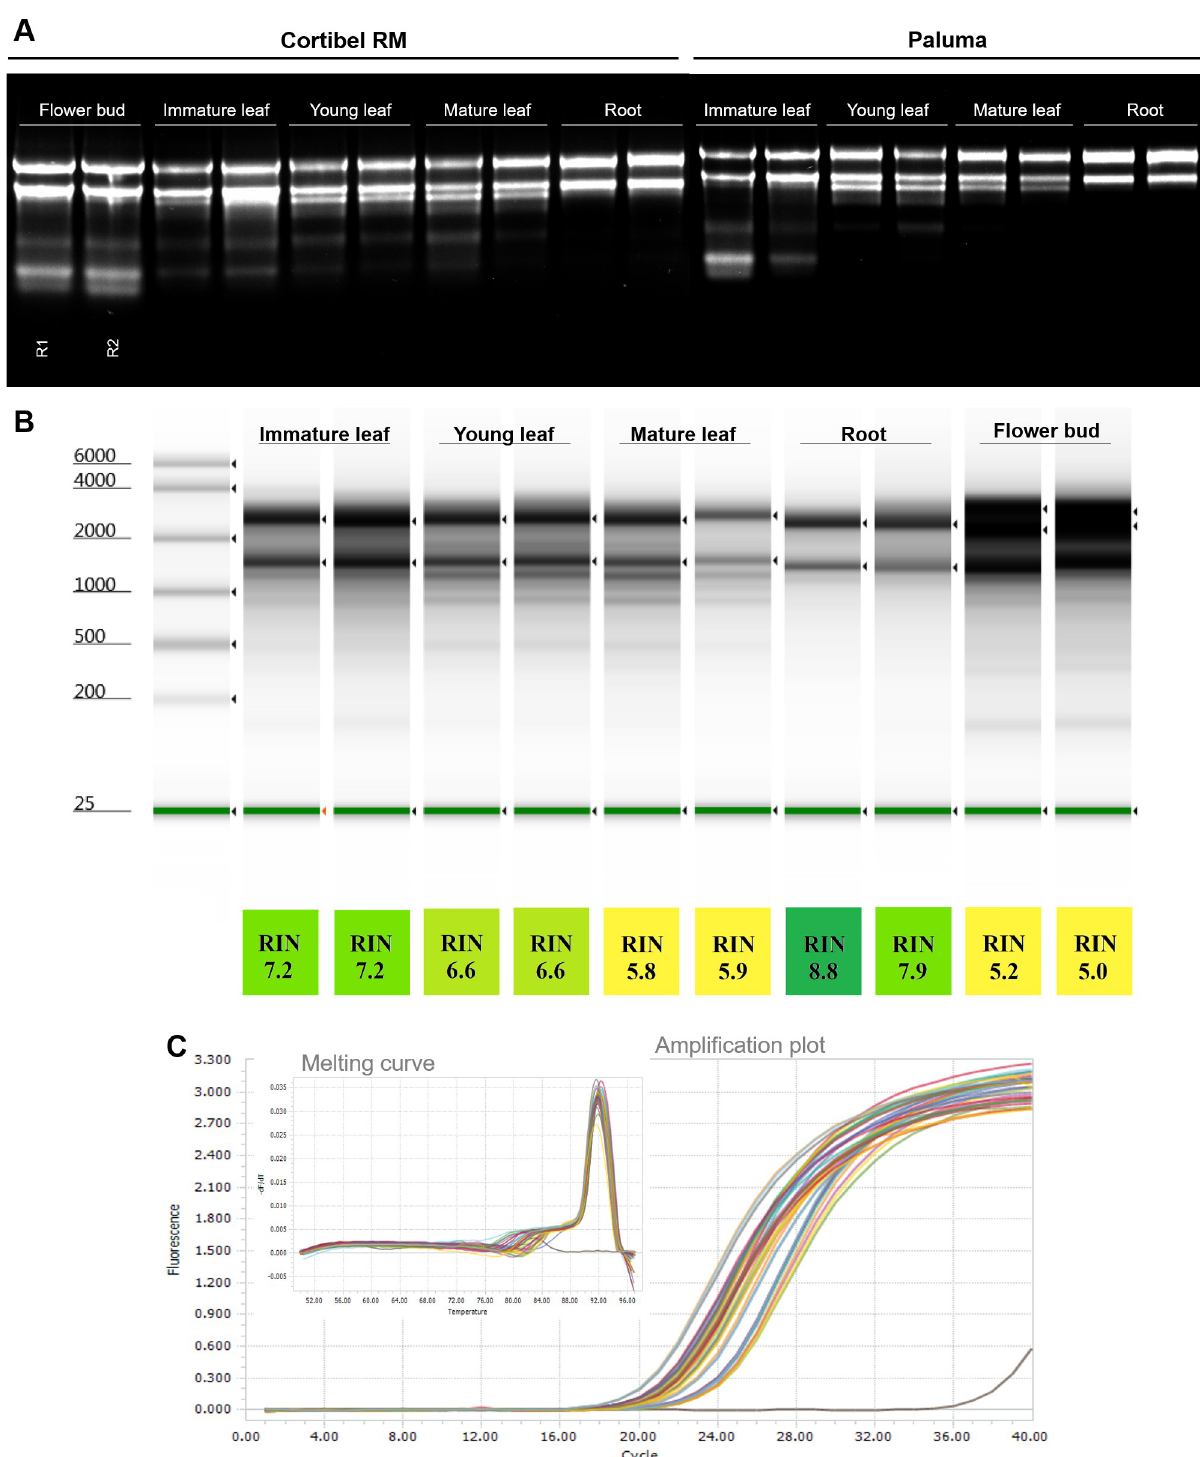
Fig 2. Qualitative analysis of RNA from different tissues. (A) Denaturing agarose gel (1%) electrophoresis of total extracted RNA (2 μ L) stained with GelRed (Biotium, Fremont-CA–USA). Extractions using the CTAB 2 protocol were done in duplicate (R1 and R2) for different tissues from two distinct genotypes of P . guajava , Cortibel RM and Paluma. (B) Quality analysis of RNA samples from Cortibel RM cultivar by TapeStation (Agilent Technologies, Santa Clara-CA–USA) using RNA ScreenTape assay, after DNase I treatment, and RIN (RNA Integrity Number) were calculated. The analyses were performed with two samples of each tissue: immature leaf, young leaf, mature leaf, root, and flower bud, respectively. (C) Quality check